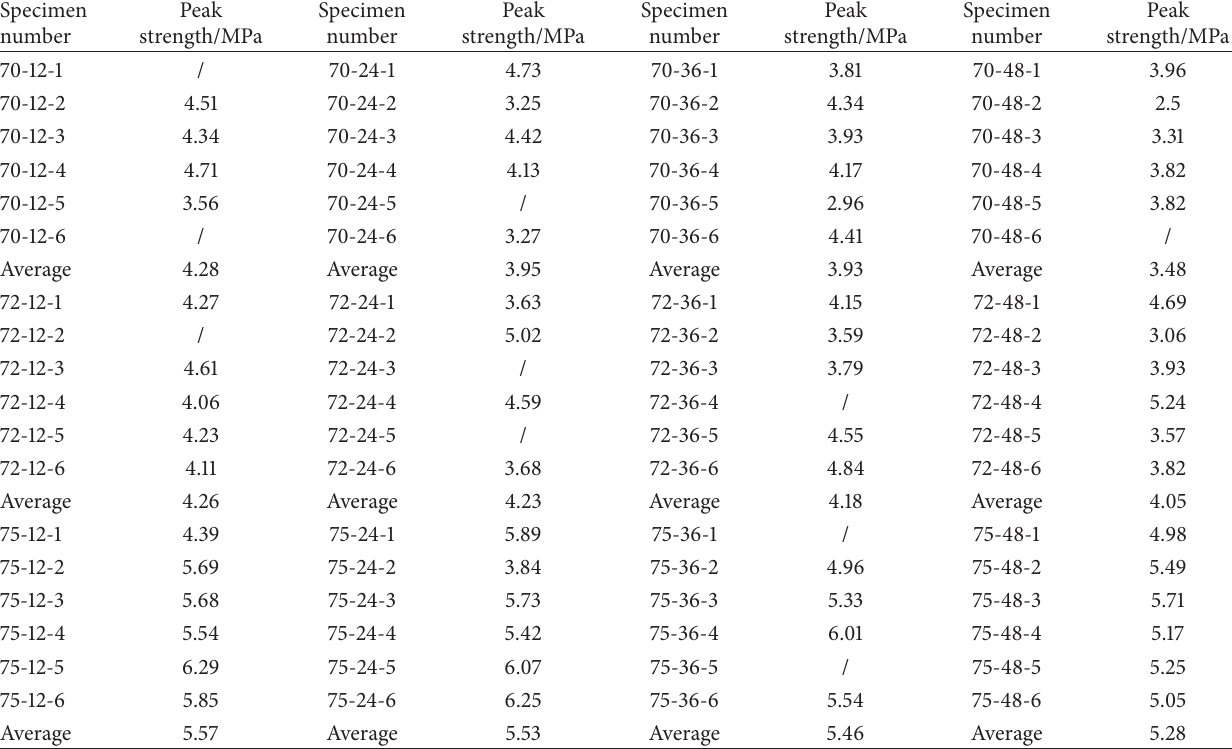
Table 2: The uniaxial compressive strength of filling material for different layers (unit: MPa).